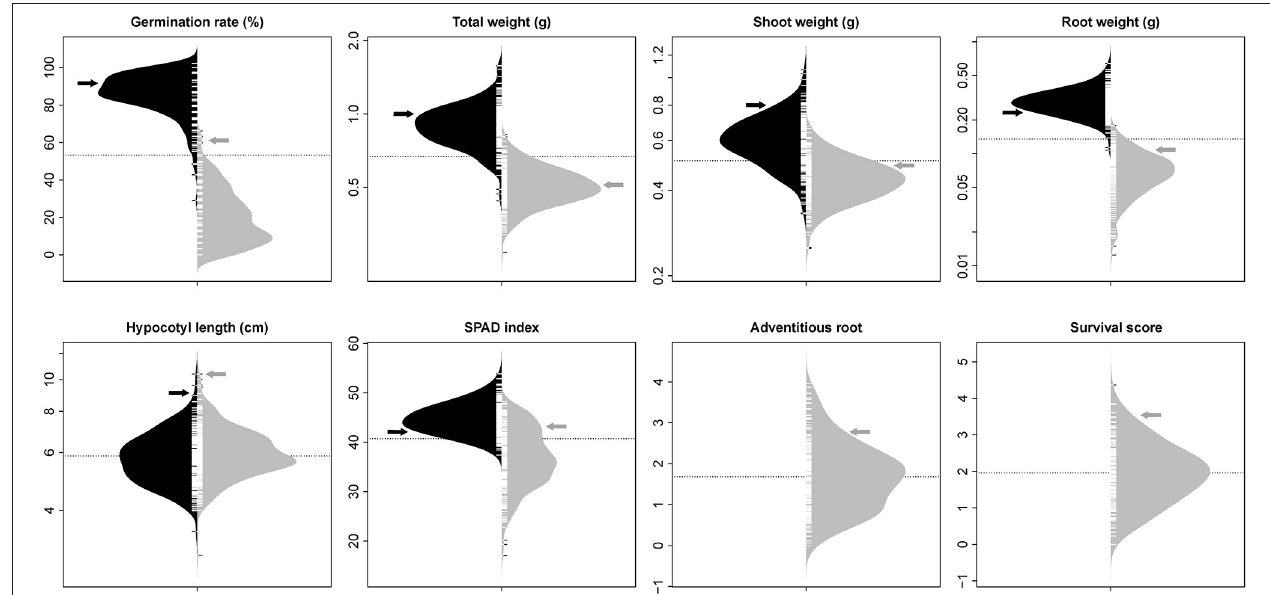
FIGURE 1 | Bean plots represent the distribution of traits in non-flooded (black) and flooded (gray) conditions. The units of y-axis for each trait was mentioned after the name of the trait on the top of each graph. The arrows indicate the values of tolerant check (Royalty) for each condition. The dotted lines indicates the total means under both flooding and control conditions. No adventitious root or survival reduction was observed in control condition.